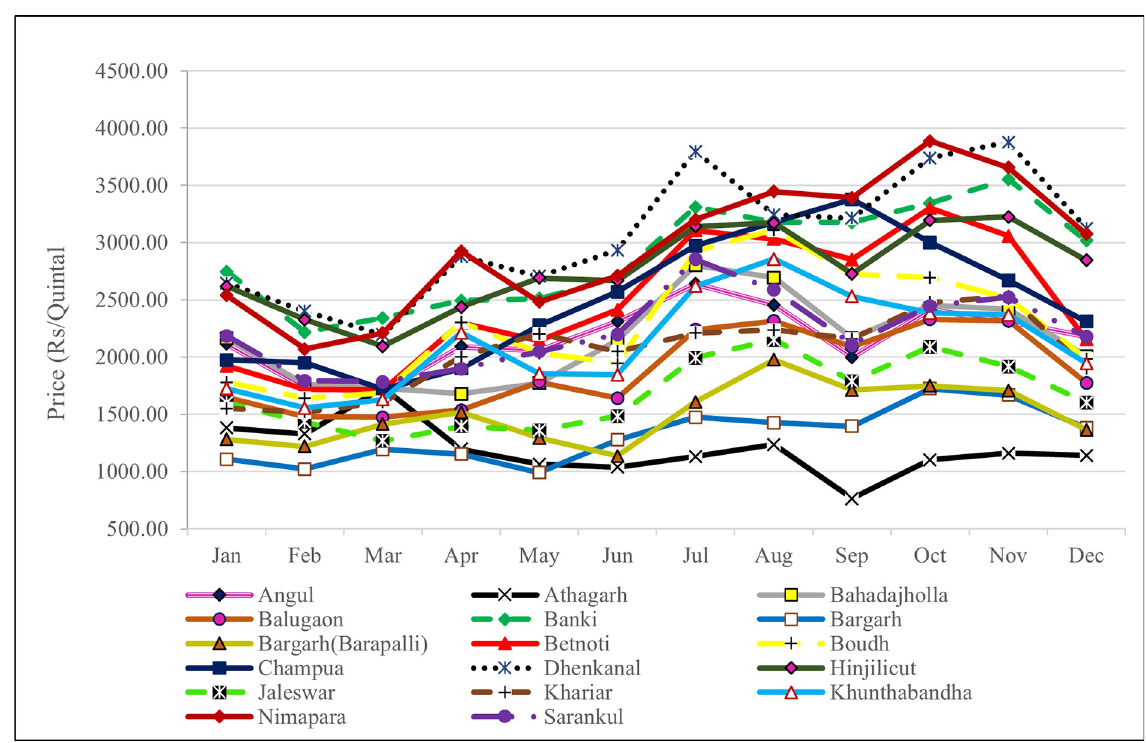
Fig 7. Average monthly price of brinjal in important markets in Odisha.